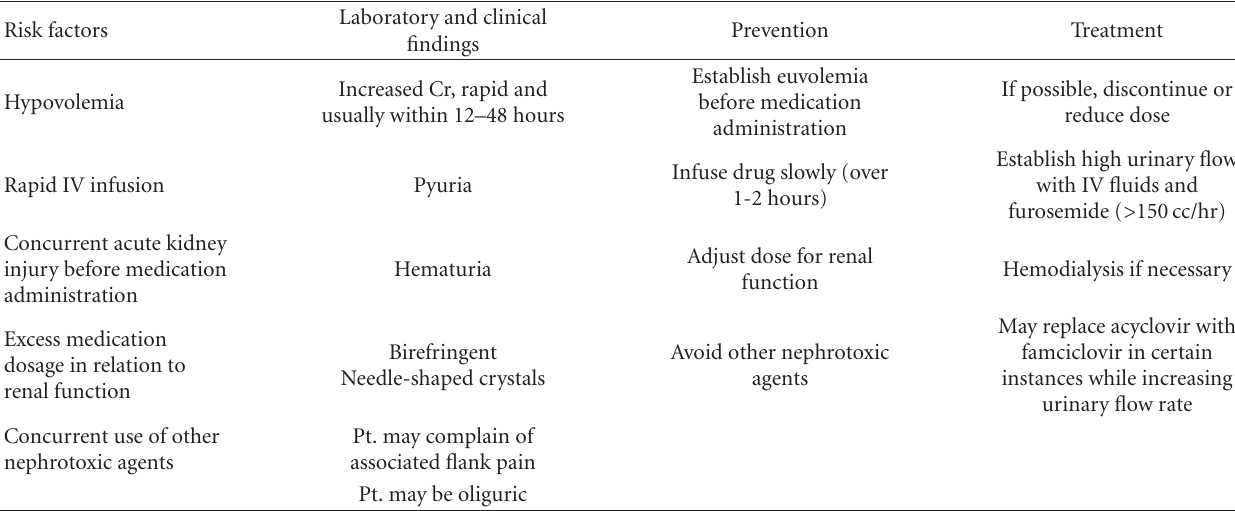
Table 1: Risks, diagnosis, prevention, and treatment of acyclovir crystal